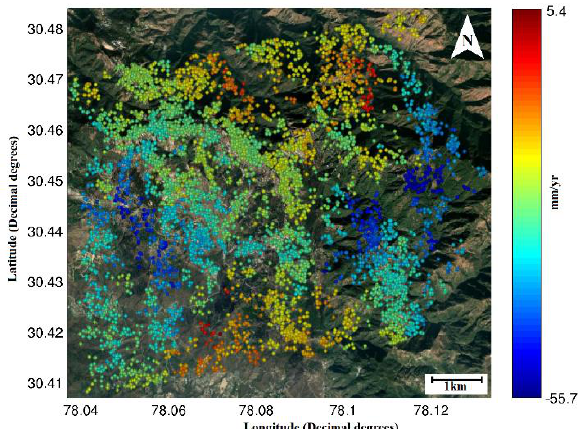
Figure 4. 1D LOS velocity plot of the Mussoorie region obtained from PSI